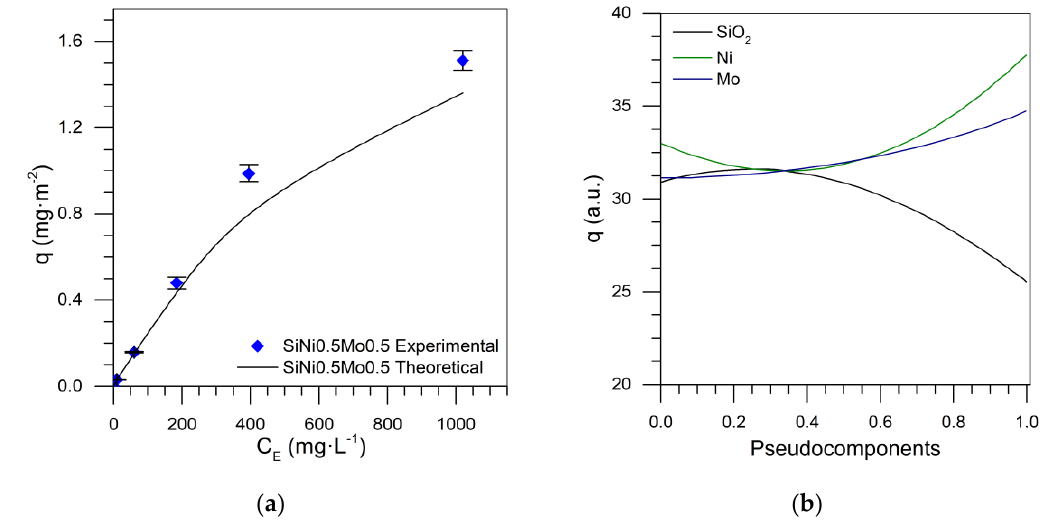
Figure 12. ( a ) Asphaltene sorption isotherms of SiNi0.5Mo0.5 at 25 °C, using experimental and theoretical data and ( b ) trace plot at 100 mg·L −1 of asphaltenes for the Si-Ni-Mo mixture.